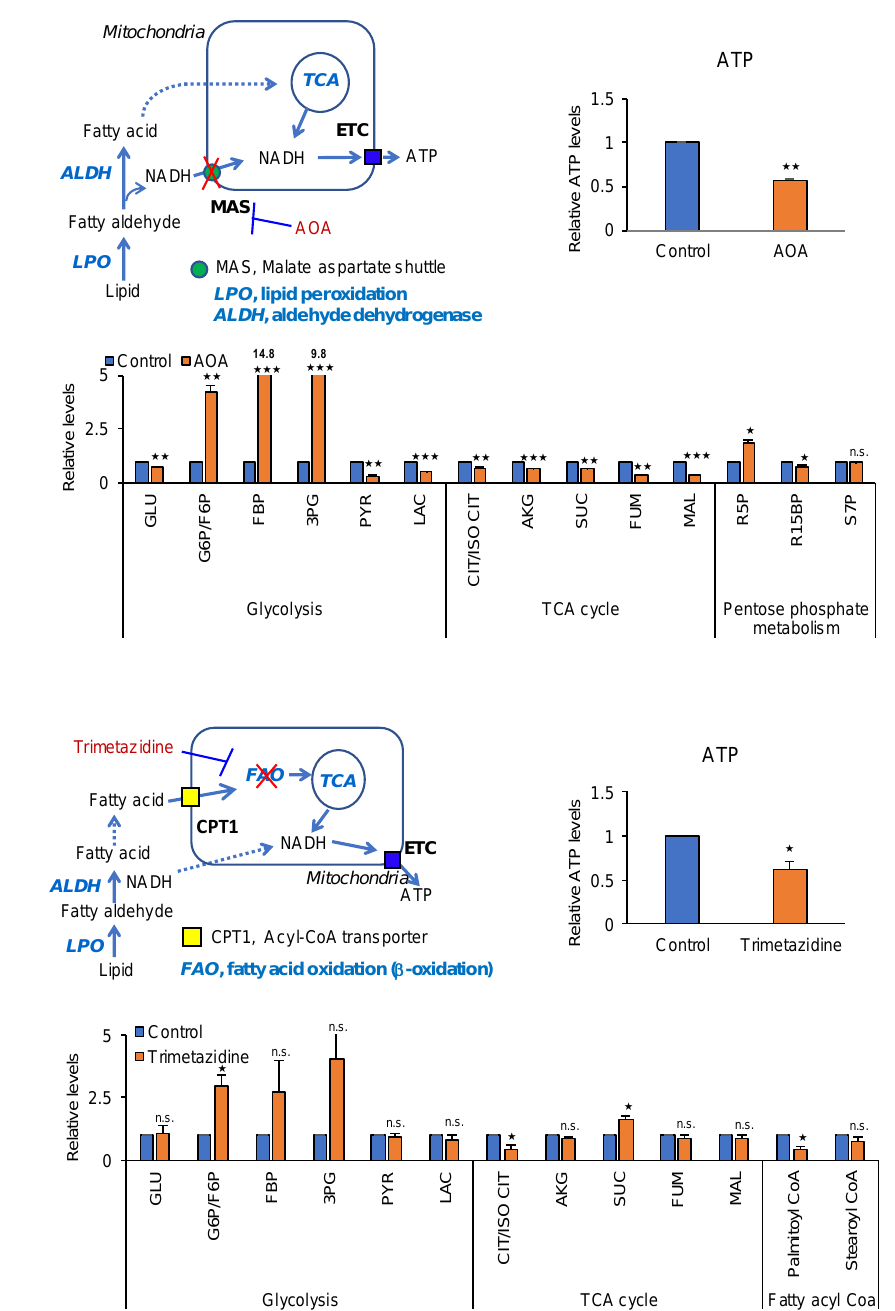
Figure 2. MAS and FAO are major contributors to ATP production in pancreatic cancer cells. Effect of blocking metabolic pathways were analyzed by relative pool sizes of metabolites using targeted LC-MS / MS after various treatments for 24 h. ( A ) glucose deprivation medium for blocking glycolysis, ( B ) 5 mM of fluoroacetate (FA) for blocking TCA cycle, ( C ) 750 µM of amino-oxy acetate (AOA) for blocking MAS system, and ( D ) 2.5 mM of trimetazidine treatments for blocking FAO in MIA PaCa-2 cells. Data represent the mean and standard deviation of three independent experiments. n.s. (not significant), * p < 0.05, ** p < 0.01, *** p < 0.001 compared with the vehicle control.